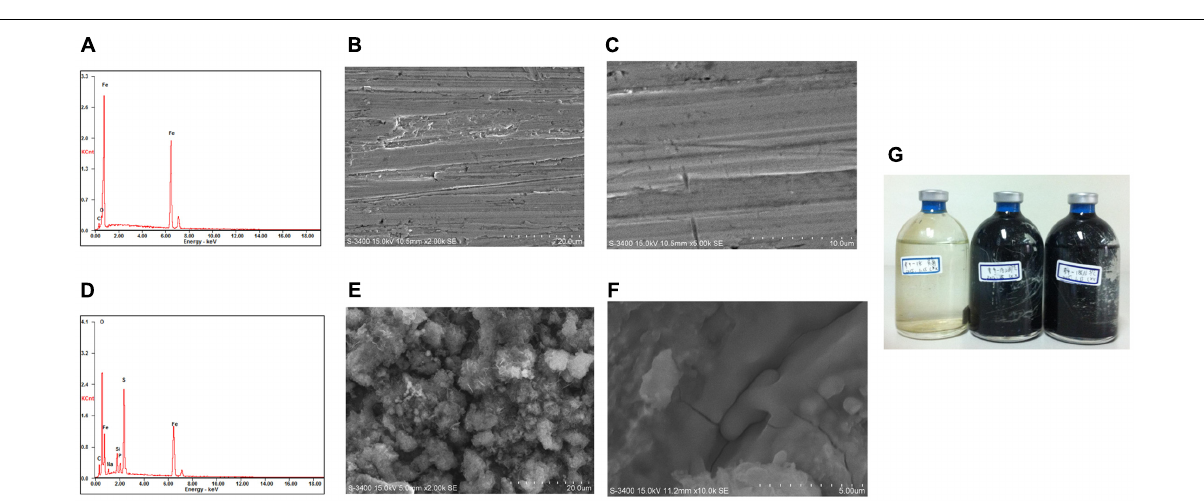
water to 76–94 mg l − 1 in the biotic incubations. The